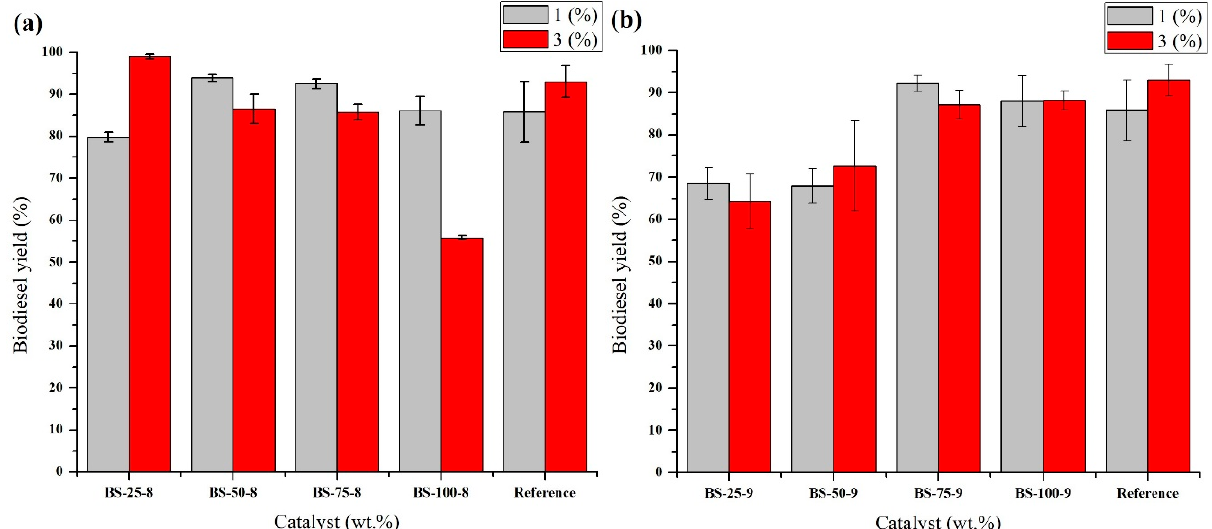
Figure 6. Biodiesel yield (%) using the catalysts obtained at ( a ) 800 °C, and ( b ) 900 °C.